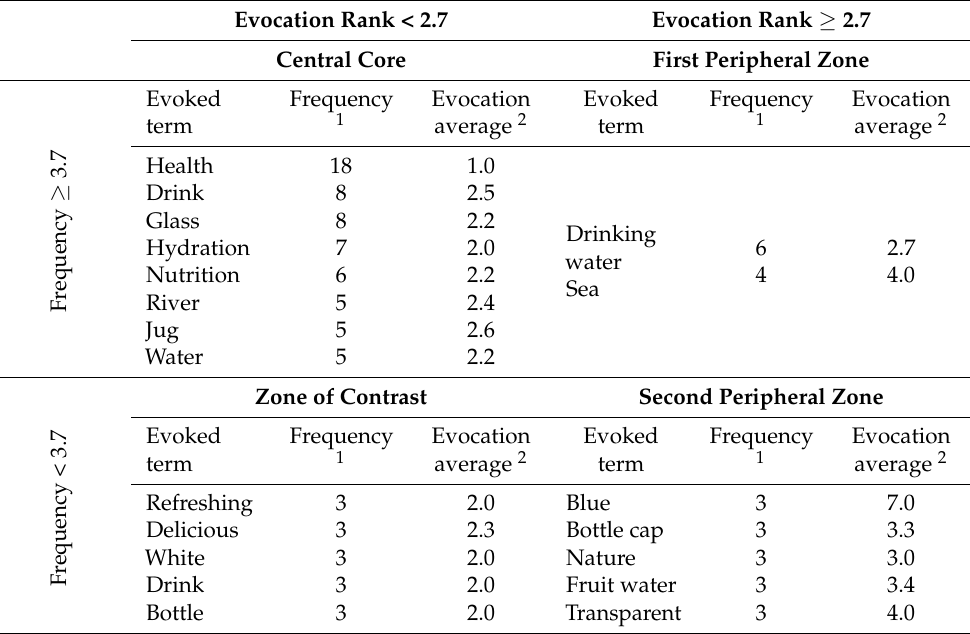
Table 1. Prototypic analysis of the social representation of “drinking water” in schoolchildren from Zapopan, Mexico ( n =